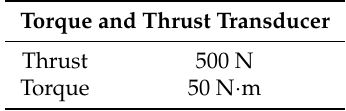
Table 2. Transducer measuring